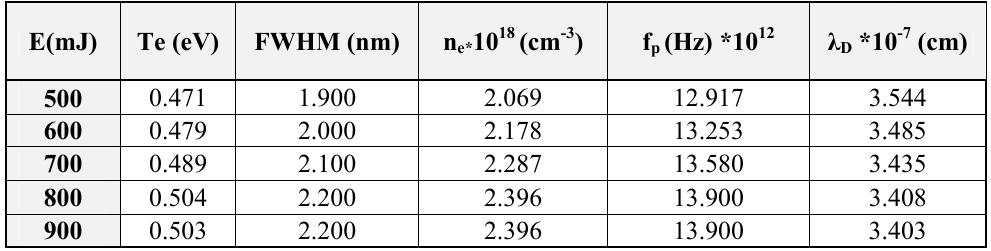
Table 2: Plasma parameters for ZnO:SnO E(mJ)